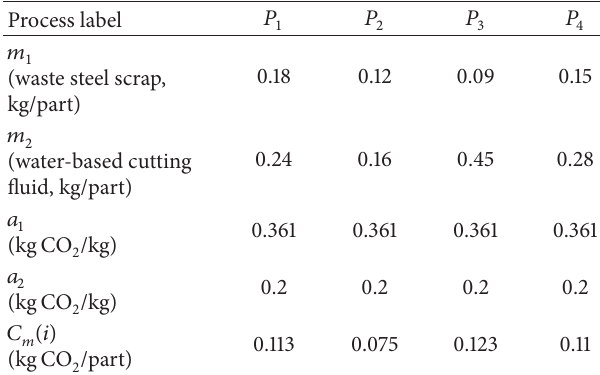
Table 3: Variables for the calculation of the material-related carbon